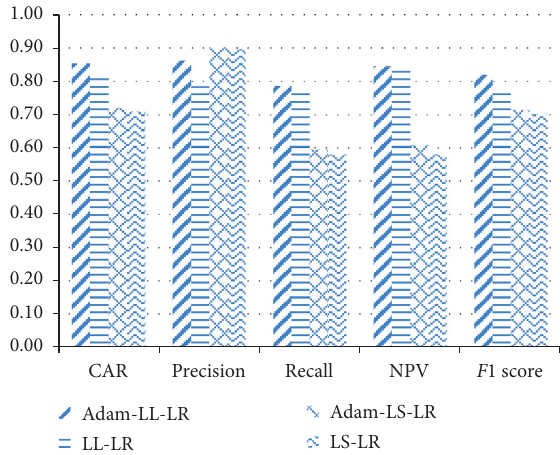
Figure 9: Performance measurement indices for the testing phase.